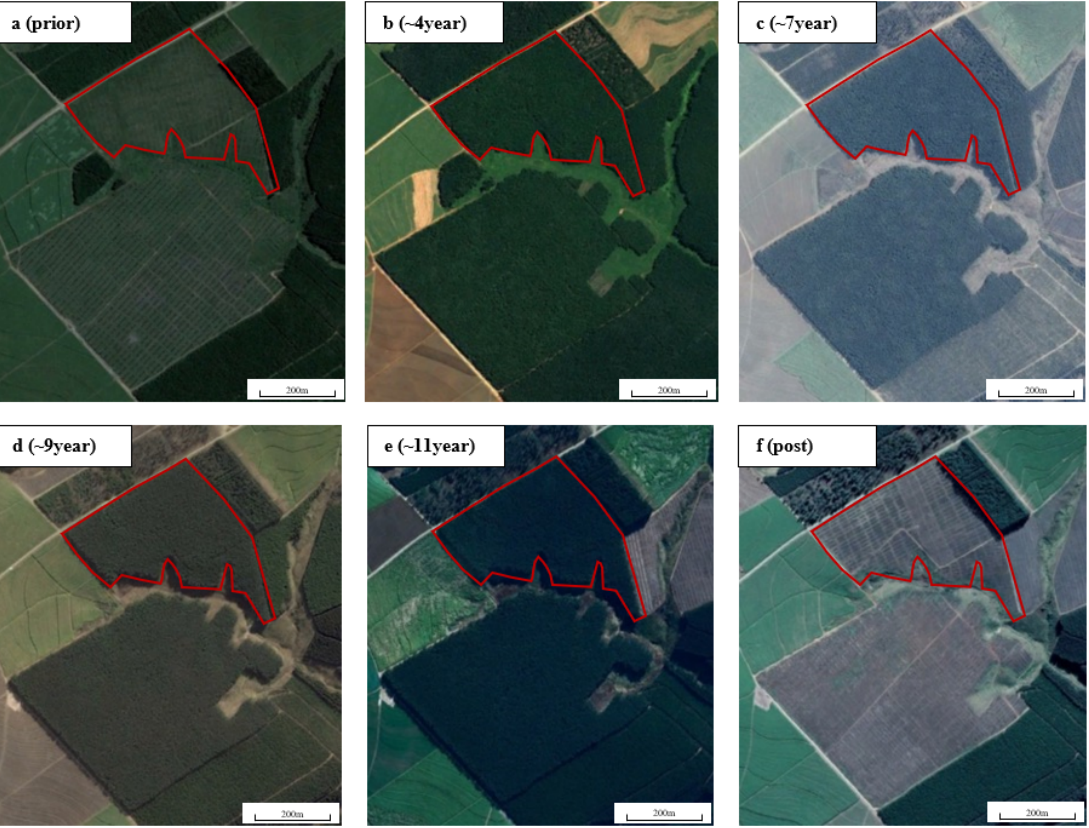
Figure 3. Two-Streams Research Catchment biomass changes in the Acacia mearnsii plantation from 2005 to 2019. Plate ( a ) represents the cleared catchment in March 2005, plate ( b ) four years of growth (February 2010), plates ( c – e ) show 2–3-year increments up to July 2017, and plate ( f ) shows the post clear-felling (June 2018).